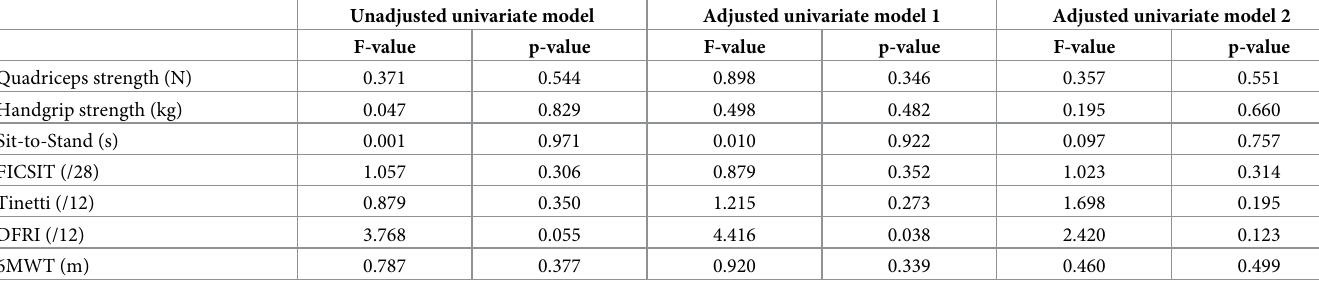
Table 8. Least squares linear regression model of the different measures of physical performance on 1-year hospitalisation